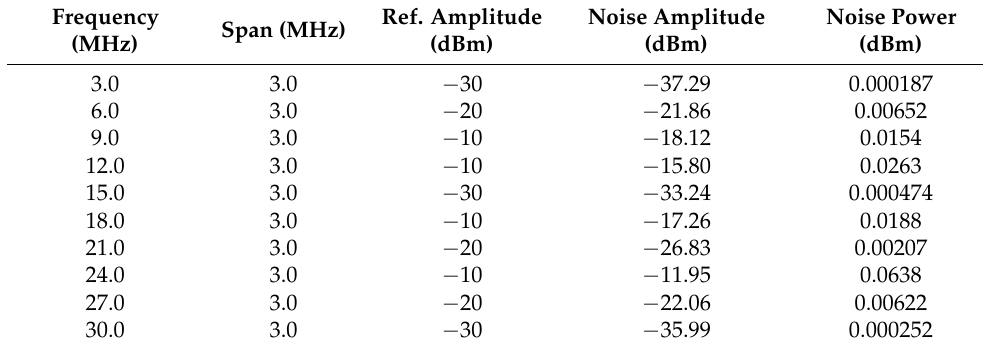
Table 4. Electric Kettle frequency domain noise amplitude and power.